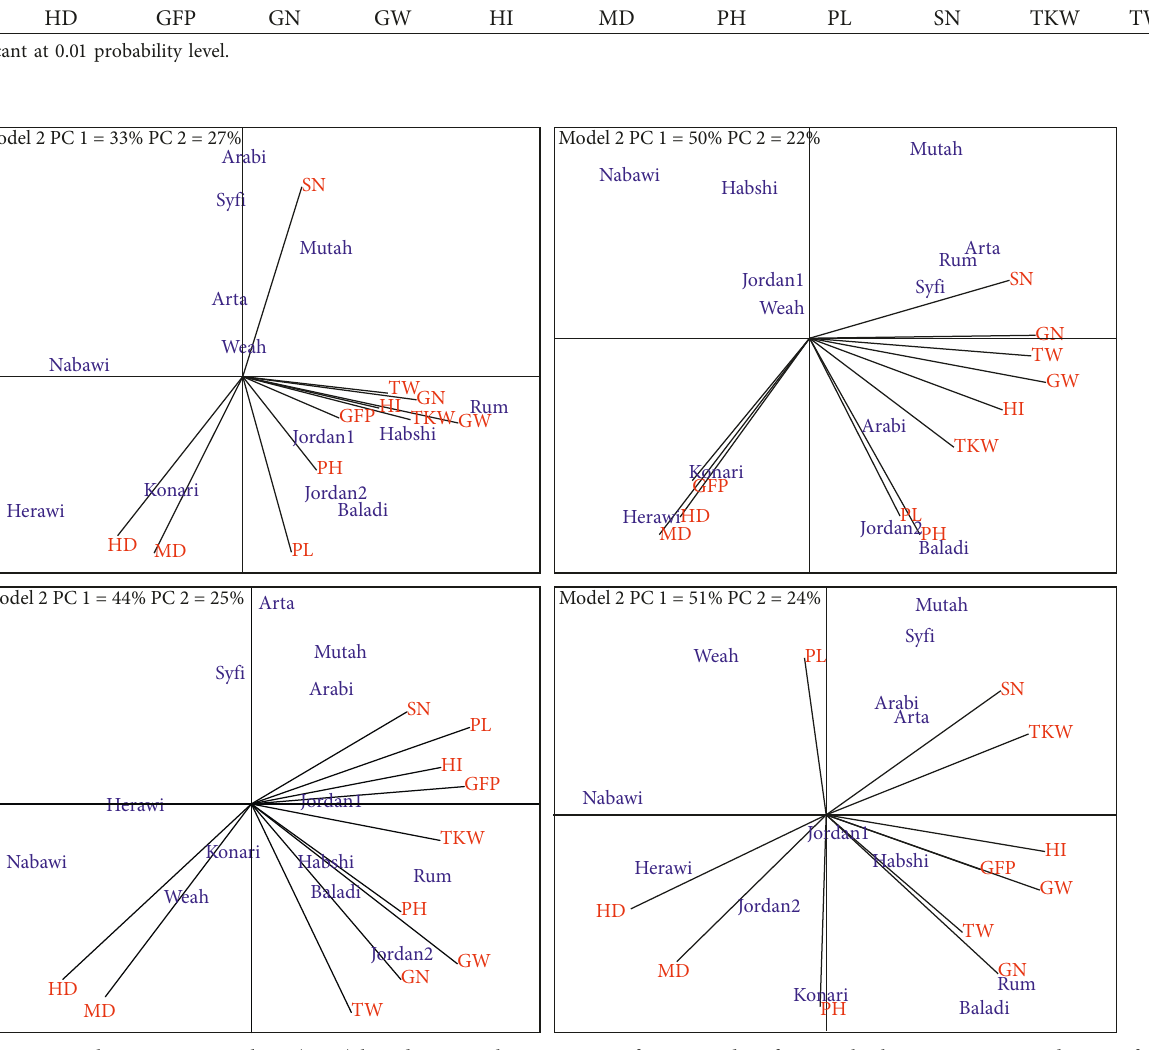
Figure 2: Principal component analysis (PCA) based on correlation matrix of 11 traits data from 13 barley genotypes tested across four environments: (a) Humid2012; (b) Dry2012; (c) Humid2013; and (d);